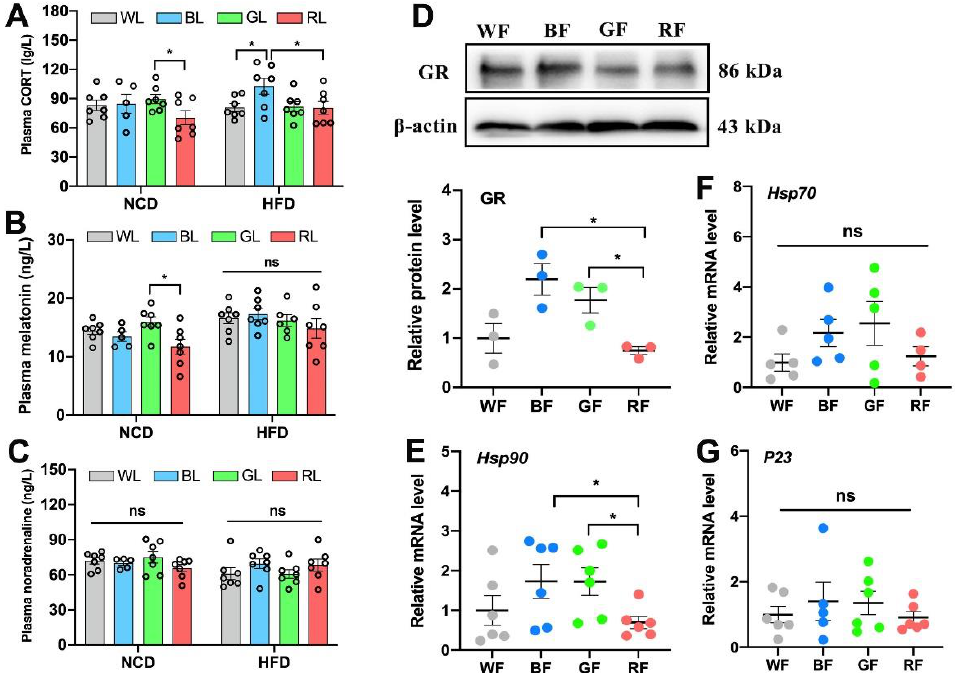
Figure 5. Influences of monochromatic light exposure on CORT concentrations. ( A – C ) Plasma concentrations of CORT, melatonin, and noradrenaline ( n = 7). ( D ) Relative protein expression level of GR in the Epi-WAT ( n = 3). ( E – G ) Relative mRNA expression levels of Hsp90, Hsp70, and P23 in the Epi-WAT ( n = 6). The circles represent the number of samples. The results are presented as the means ± SEM. * p < 0.05.